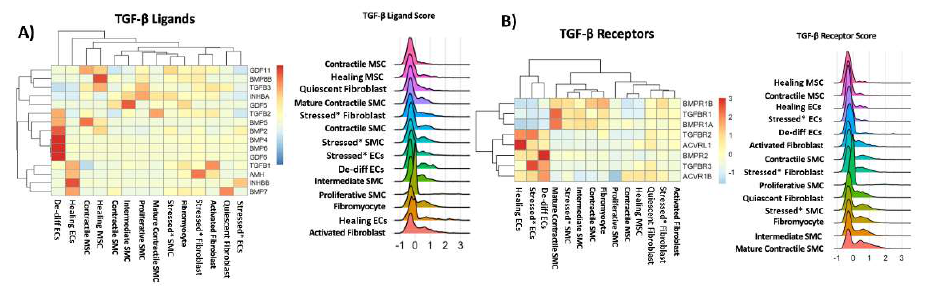
Figure 4. Cell-specific expression of genes in the TGF-β pathway. Expression patterns and composite score of ( A ) TGF-β ligands and ( B ) TGF-β receptors across non-immune cell clusters.